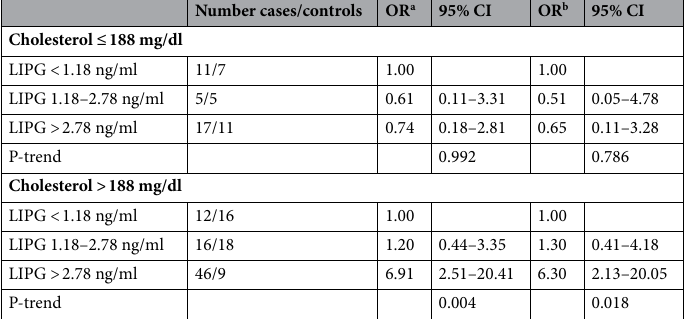
Table 5. LIPG and risk of breast cancer by total cholesterol. a Adjusted for age at diagnosis (cases) and age at interview (controls). b Further adjusted for age at menarche, parity, menopausal status, BMI, and family history of breast/ovarian cancer.